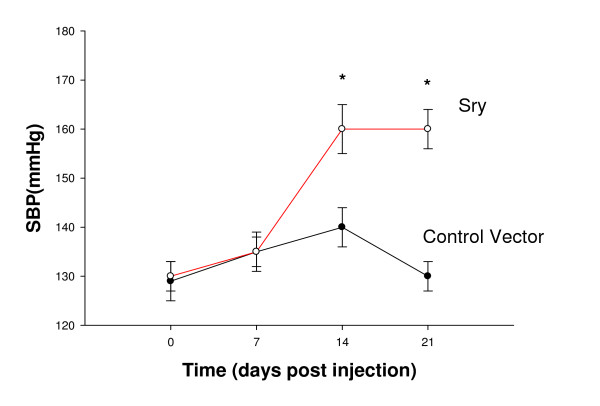
Systolic blood pressure (SBP) in the vector controls vs Sry injected at baseline weekly for 3 weeks (means, =/-s.e.m., * = p < .05).